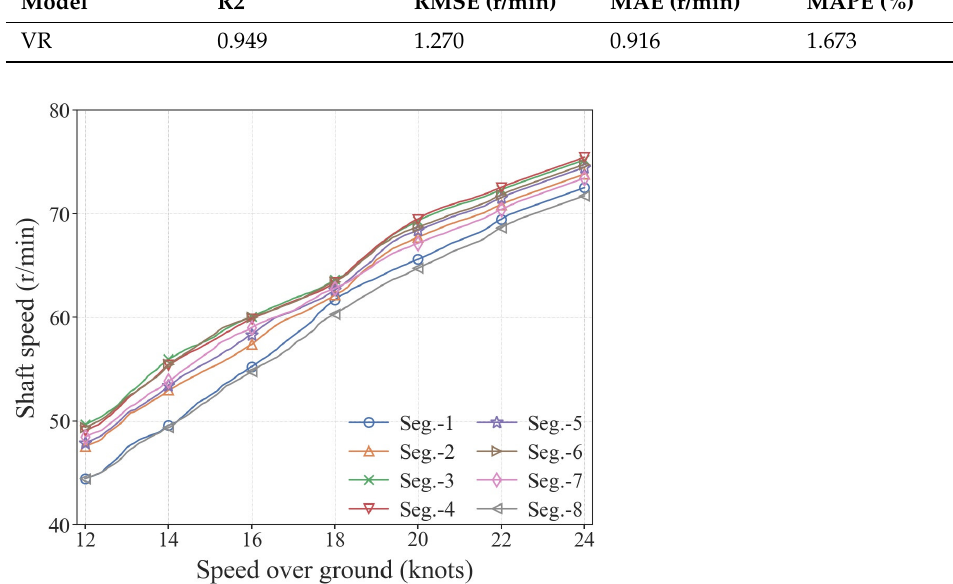
Figure 3. The trend prediction reliability of the shaft speed prediction model on test segments.